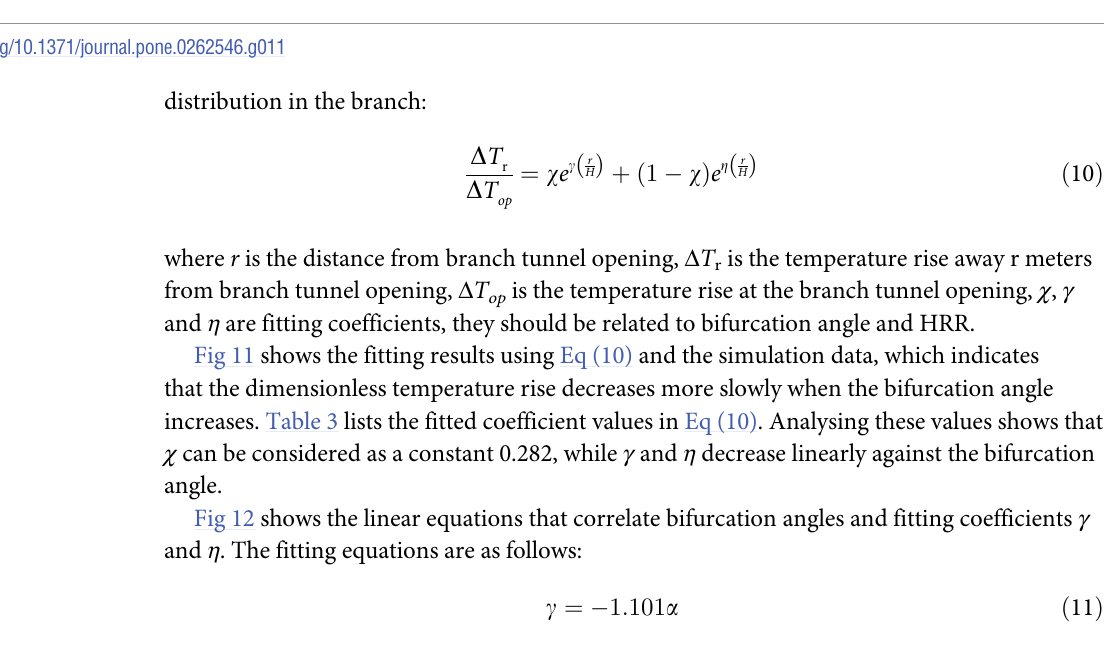
) against dimensionless distance ( r / H ) along longitudinal direction of branch tunnel with HRR op